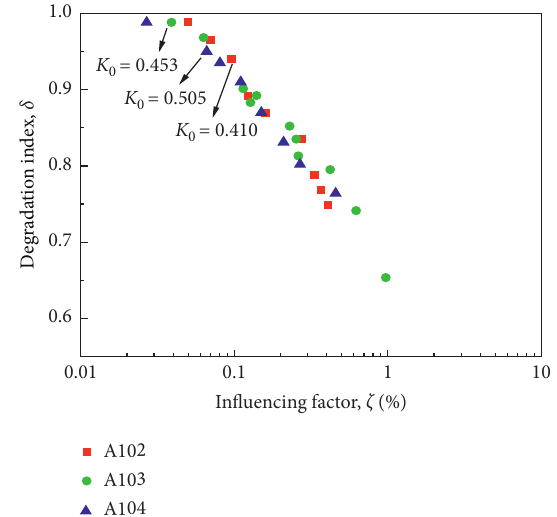
Figure 15: Relationship of the degradation index δ − ζ for different K